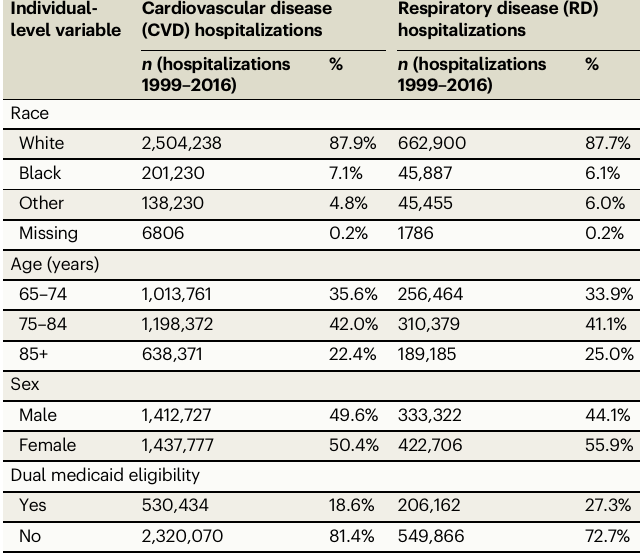
Table 1 | Summary statistics for Medicare hospitalizations for included ZIPS ( n = 796) in Florida, 1999 – 2016 Individual- Cardiovascular disease level variable (CVD)